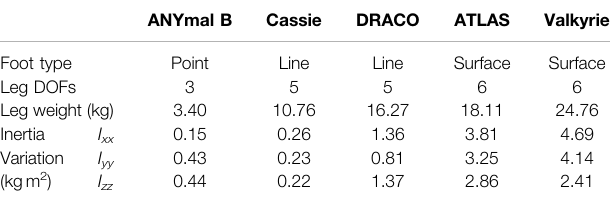
TABLE1| Summaryofpropertiesofvariousleggedrobots.Wehavesampled10 5 random con fi gurations for all robots, computed the centroidal inertia tensor, and calculated the standard deviations for I xx , I yy , and I zz